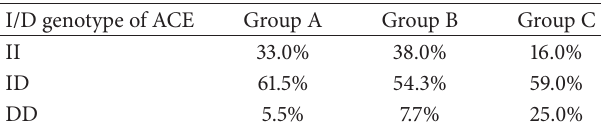
Table 3: Distribution of genotypes related to insertion-deletion ACE gene polymorphism in 55 ADPKD